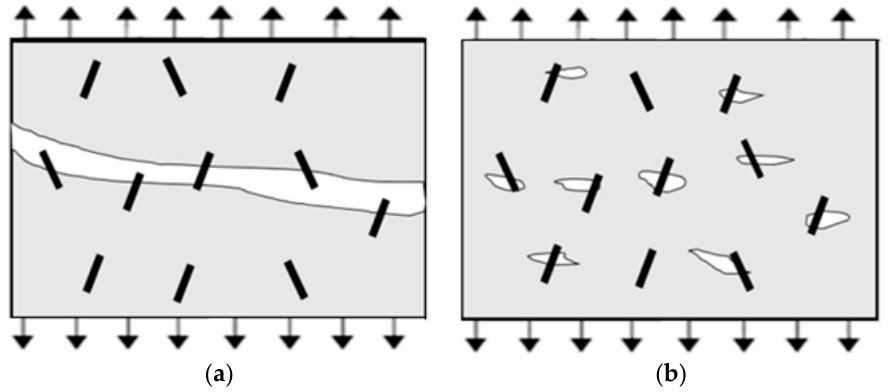
Figure 13. Mechanism of short-fiber reinforcement: ( a ) concrete with macrocracks and ( b ) concrete with microcracks.